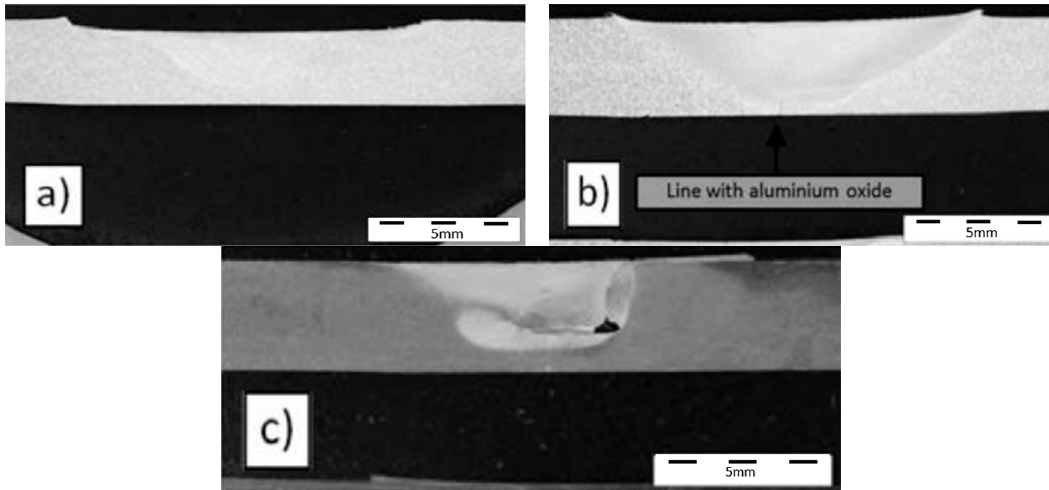
Figure 4. Macroscopic image of AA5083 joints by ( a ) optimal heat input, ( b ) high heat input and ( c ) low heat input [48] .